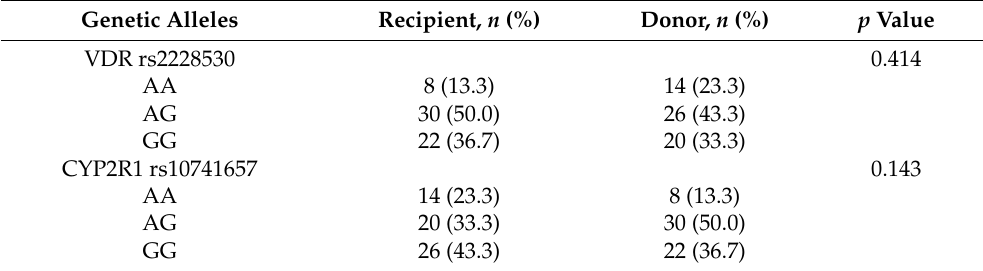
Table 2. Single nucleotide polymorphisms of vitamin D receptor and CYP2R1 in 60 pairs of recipients and donors who underwent living donor liver